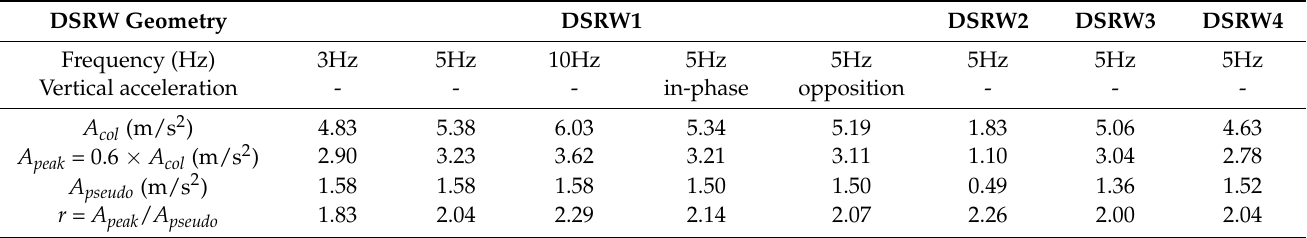
Table 8. Comparison of the collapse acceleration A col , the estimated peak acceleration A peak and the pseudo-static resistance A pseudo , along with the estimated behaviour factor r for every single numerical case in this study. When the vertical acceleration is accounted for, the displayed accelerations only show the horizontal components, the vertical ones being always half of the